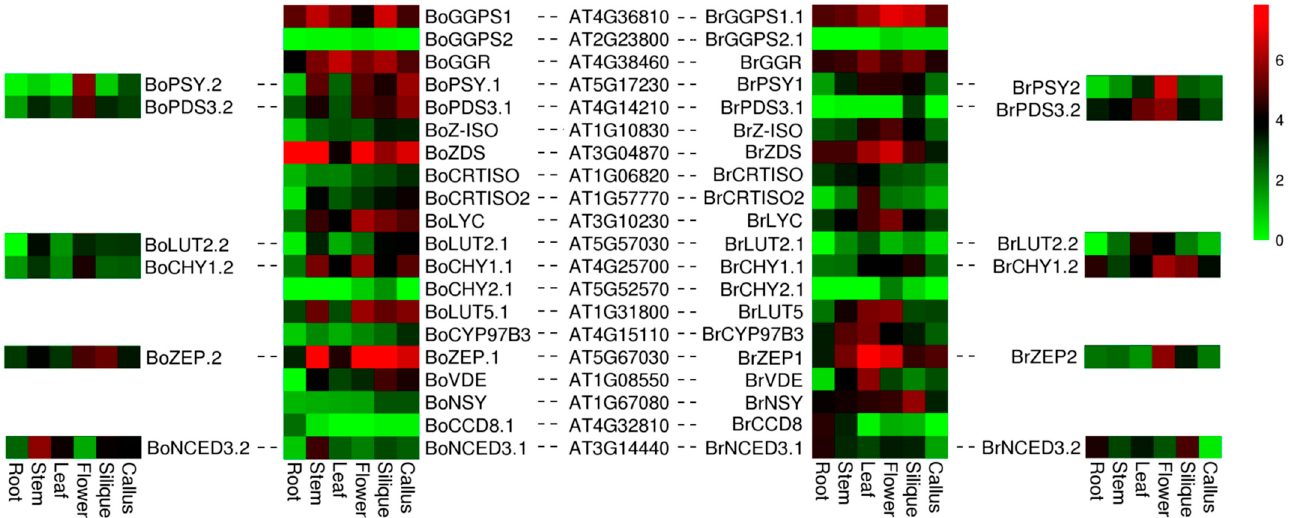
Figure 4. Heat map representation of orthologous gene pairs of carotenoid biosynthetic genes of B. oleracea and B. rapa . Color scale bar represents log 2 transformed FPKM values.